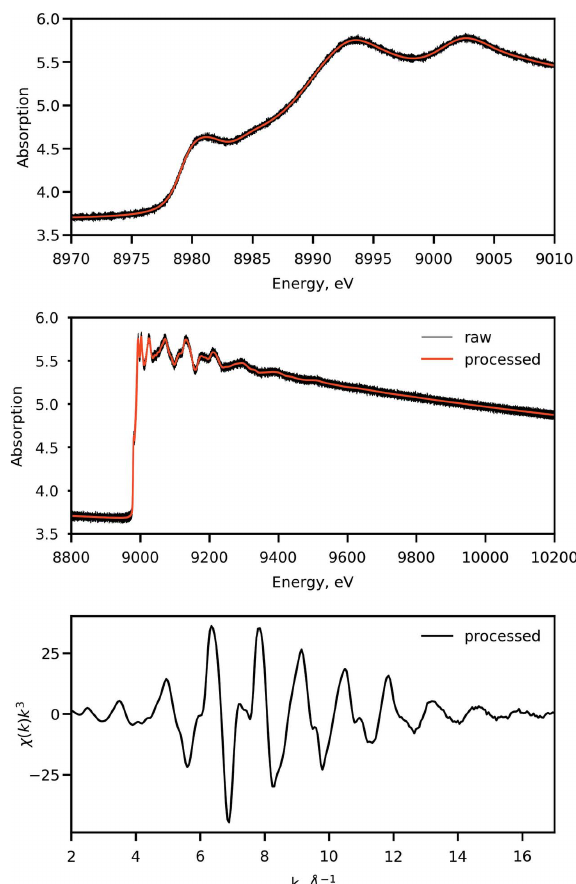
Figure 7 Example of a spectrum measured at ISS on a copper foil at the Cu K -edge at 8979 eV using the energy-down portion of the trajectory shown in Fig. 3. (Top) Zoom on the XANES region of the spectrum. The raw spectrum is overlaid with the processed spectrum obtained using the Gaussian filtering as explained in the text. (Middle) Overview of the entire spectrum recorded using the trajectory. The legend and the ordinate scale are shared between top-left and top-right panels. (Bottom) The k 3 -weighted (cid:4) ( k ) function obtained after normalization and back- ground removal of the processed absorption spectrum using LARCH (Newville,